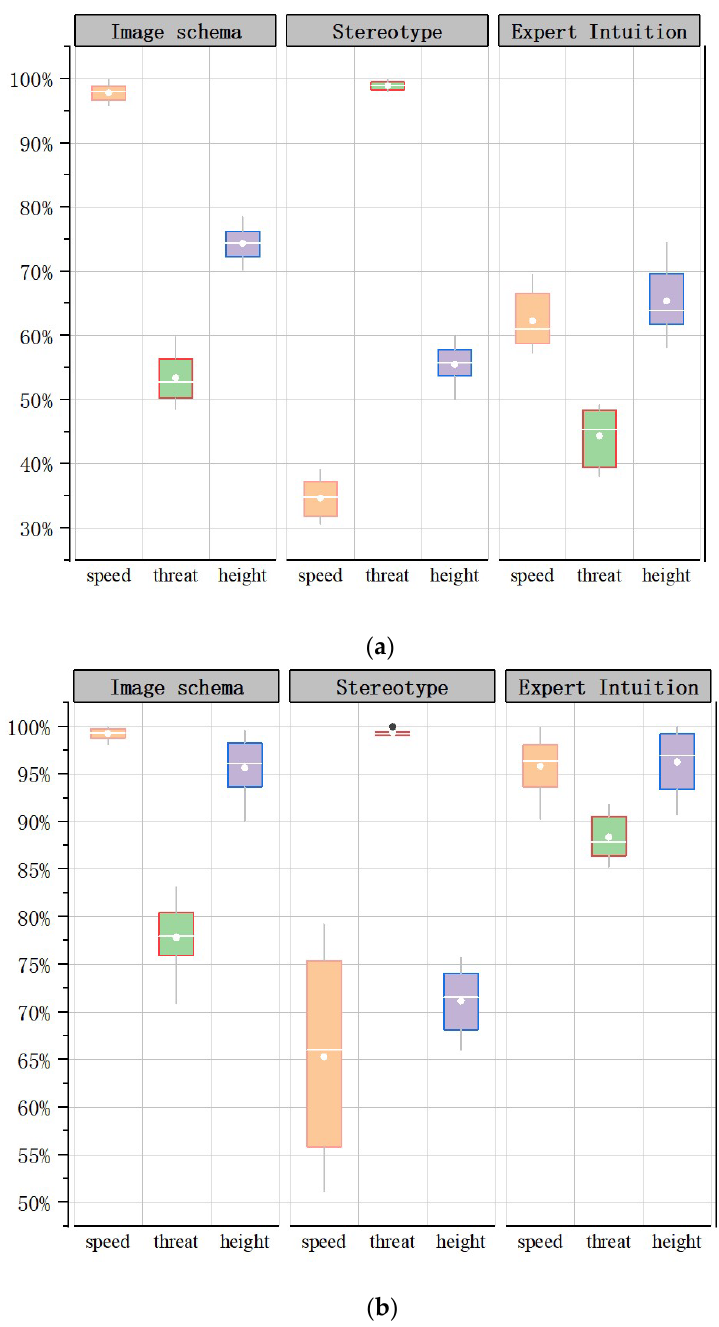
Figure 3. Accuracy box line chart. ( a ) 2000 ms ACC; ( b ) 4000 ms ACC.